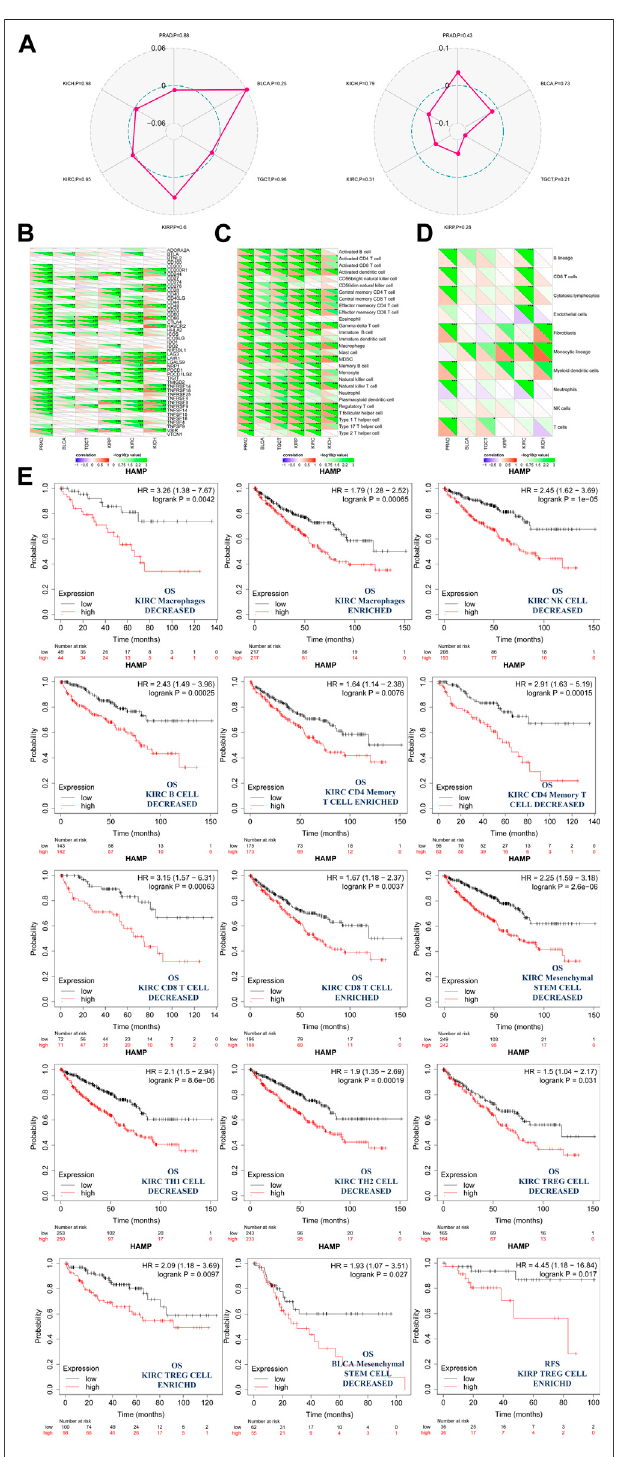
FIGURE6| Analysisbetweenhepcidinexpressionandcancerimmunity. (A) Correlations between hepcidin levels and tumor mutational burdens (left panel)/microsatellite instabilities (right panel). (B) Correlations between expression of hepcidin and immune checkpoints. Correlations between hepcidin levels and (C) immune response pathways and (D) immune cell score * p < 0.05; ** p < 0.01; *** p < 0.001. (E) Associations between hepcidin